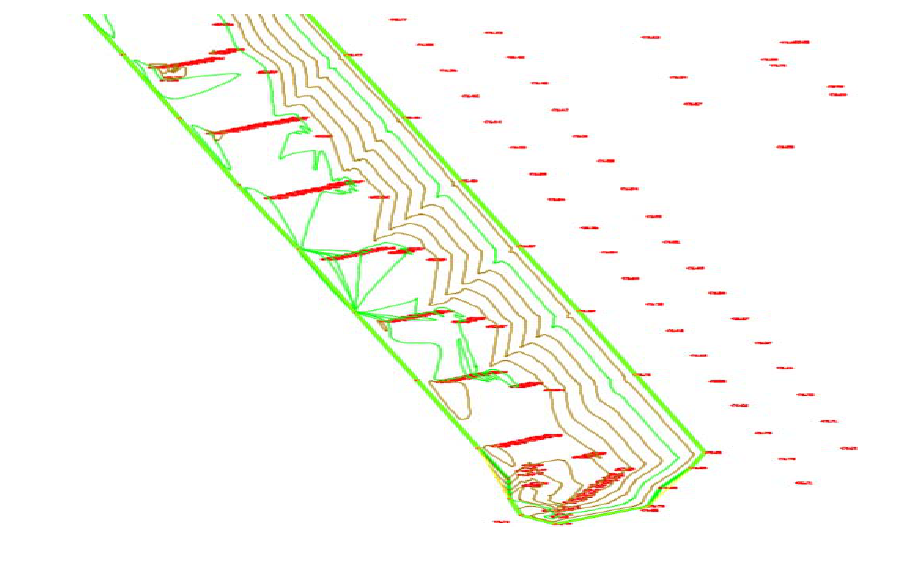
Figure 12 – Appearance of the isohypses of the created DTM Рис . 12 – Вид изогипсы , разработанной ЦММ Слика 12 – Изглед изохипси креираног